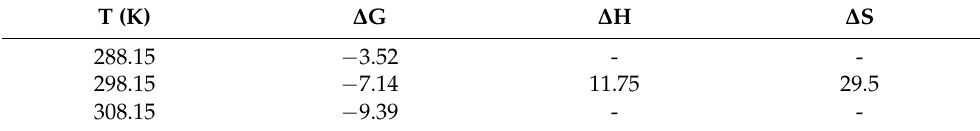
Table 4. The linear regression of the adsorption thermodynamic model of Hg 2+ for the CB. T (K) ∆ G ∆ H ∆ S